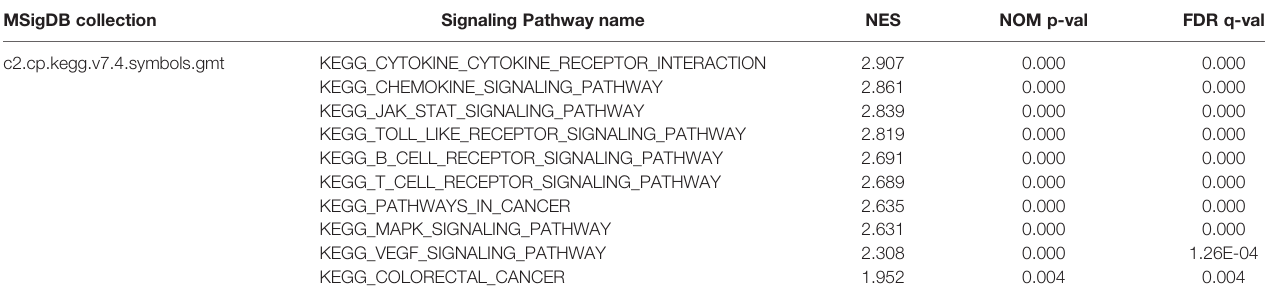
TABLE 3 | Gene set enrichment analysis (GSEA) of CSF-1R in COAD. MSigDB